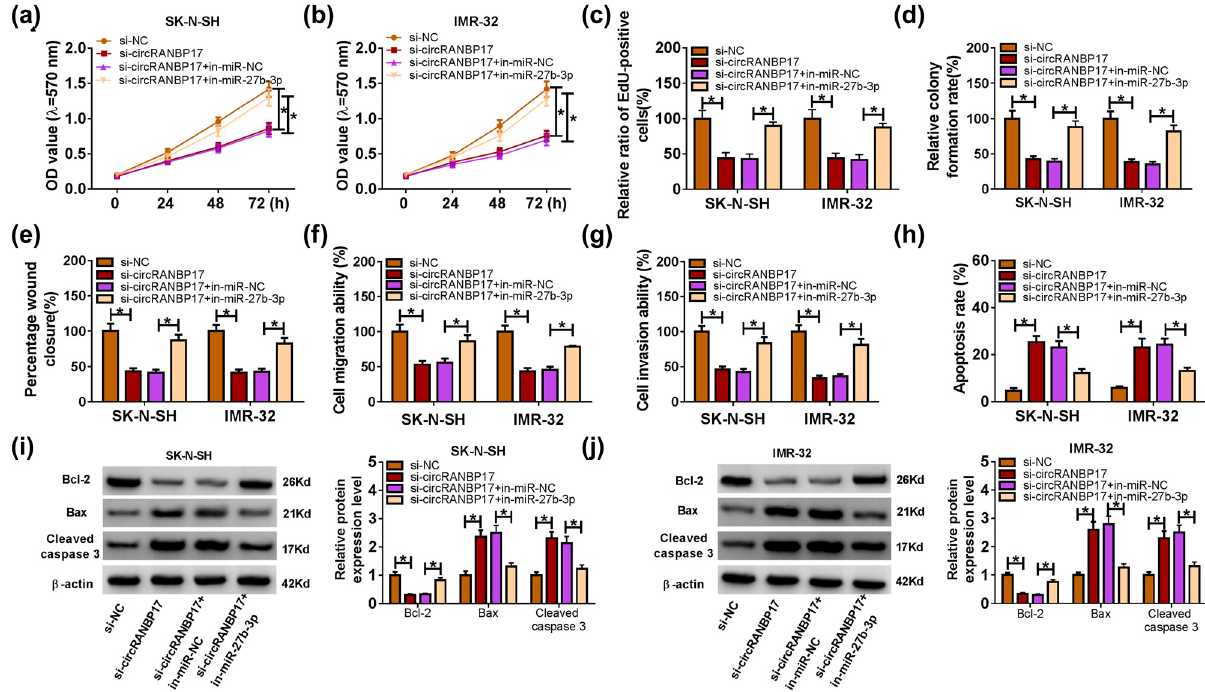
Figure 5: miR - 27b - 3p inhibitor restrains the inhibitory e ff ects on cell proliferation, migration, invasion and the promoting e ff ect on cell apoptosis induced by circRANBP17 knockdown in SK - N - SH and IMR - 32 cells. Cell proliferative capacity ( a – d ) , migration ability ( e and f ) , invasion ability ( g ) , apoptosis rate ( h ) and the protein levels of Bcl - 2, Bax and Cleaved caspase 3 ( i and j ) in SK - N - SH and IMR - 32 cells transfected with si - circRANBP17, si - circRANBP17 + in - miR - 27b - 3p, or their matched controls were assessed by MTT, EdU and cell colony formation assays, wound - healing assay, Transwell assay, fl ow cytometry and western blot, respectively. * P <